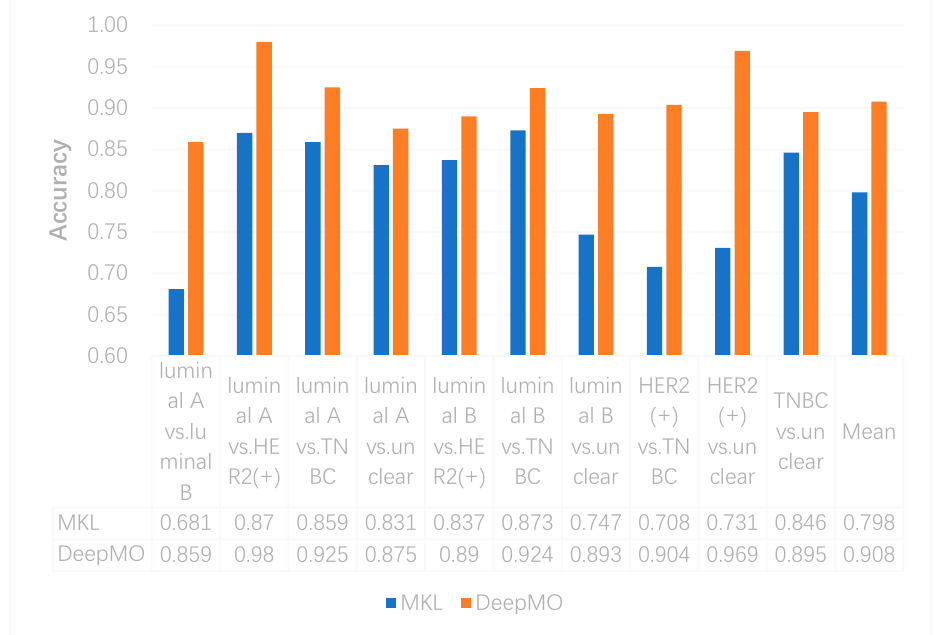
Figure 2. The accuracy by using multiple kernel learning (MKL) and DeepMO on binary classification.